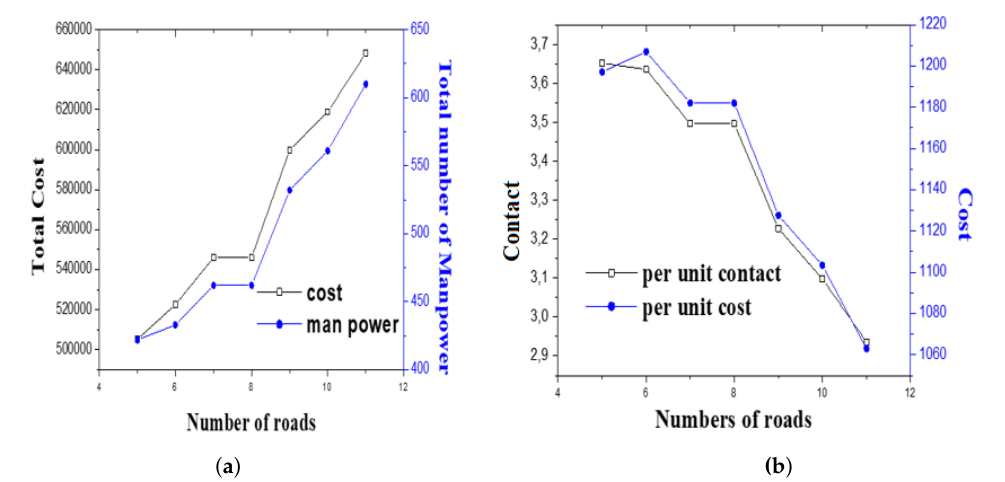
Figure 2. ( a ) Total cost vs. total manpower ( b ) Average rule violation vs. average allocation